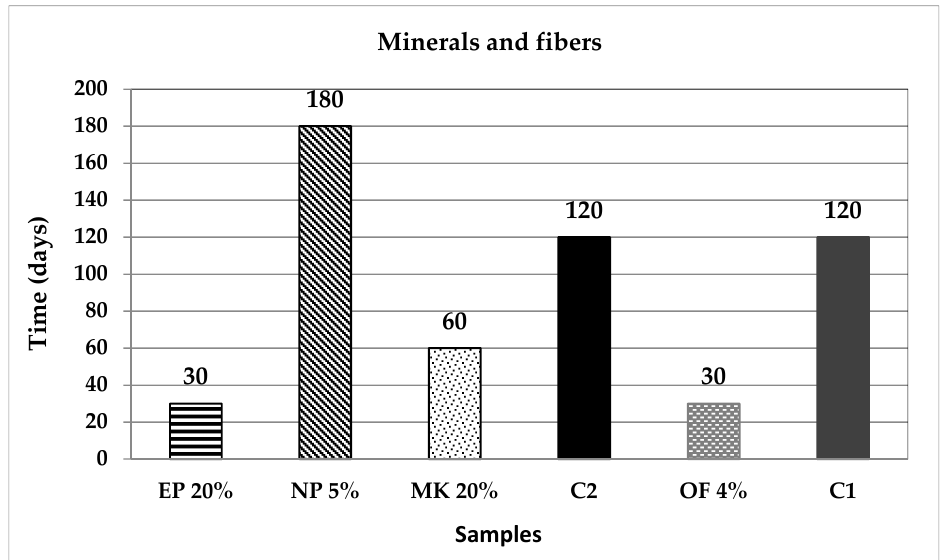
Figure 12. Critical time to reach out 25 mm of carbonation front, for the minerals and fibres group of additions.